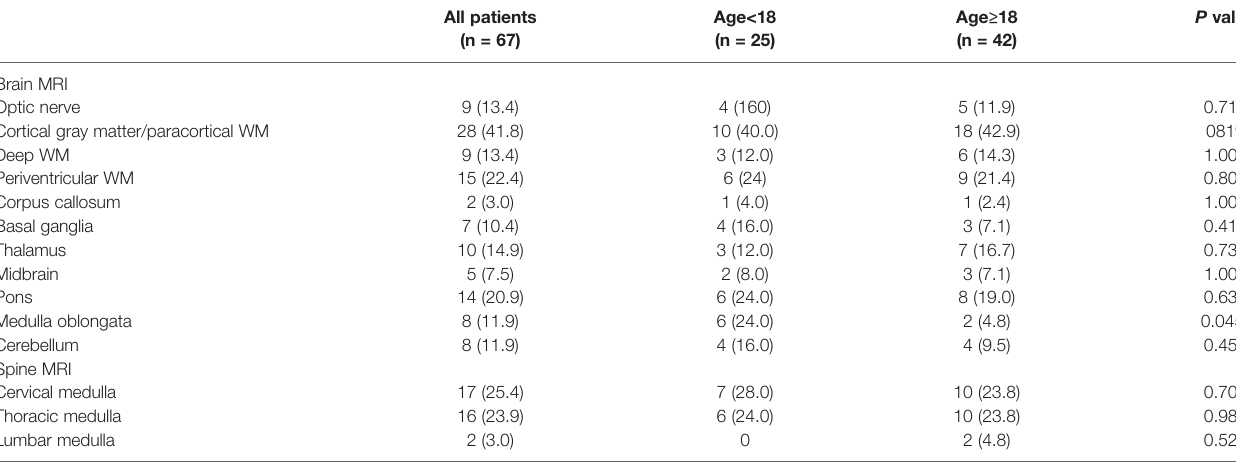
TABLE 4 | Patients ’ radiological characteristics.